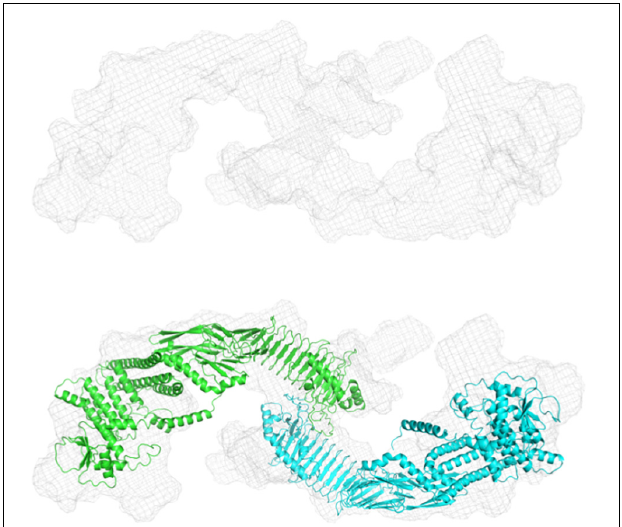
FIGURE 3 | Ab initio and rigid body modeling of refolded pro-HlyA. Upper panel: Volumetric envelope of the GASBORMX ab initio model. Lower panel: Overlay of the ab initio and the dimer model. The single monomers are colored in cyan and